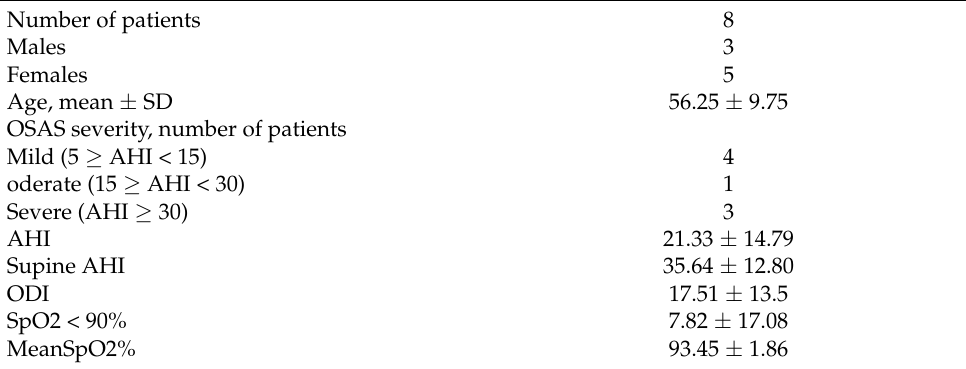
Table 1. Characteristics of the whole population at baseline (T0).